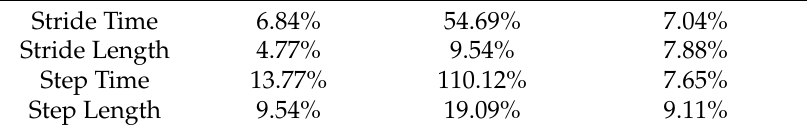
Table 3. Estimation of a relative error using an RGB-D camera and the Optotrak gait parameters as a